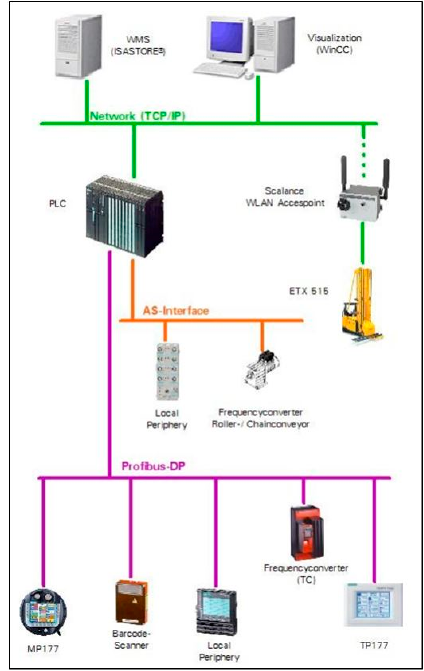
Figure 4. Pallet Automation System Network Diagram.